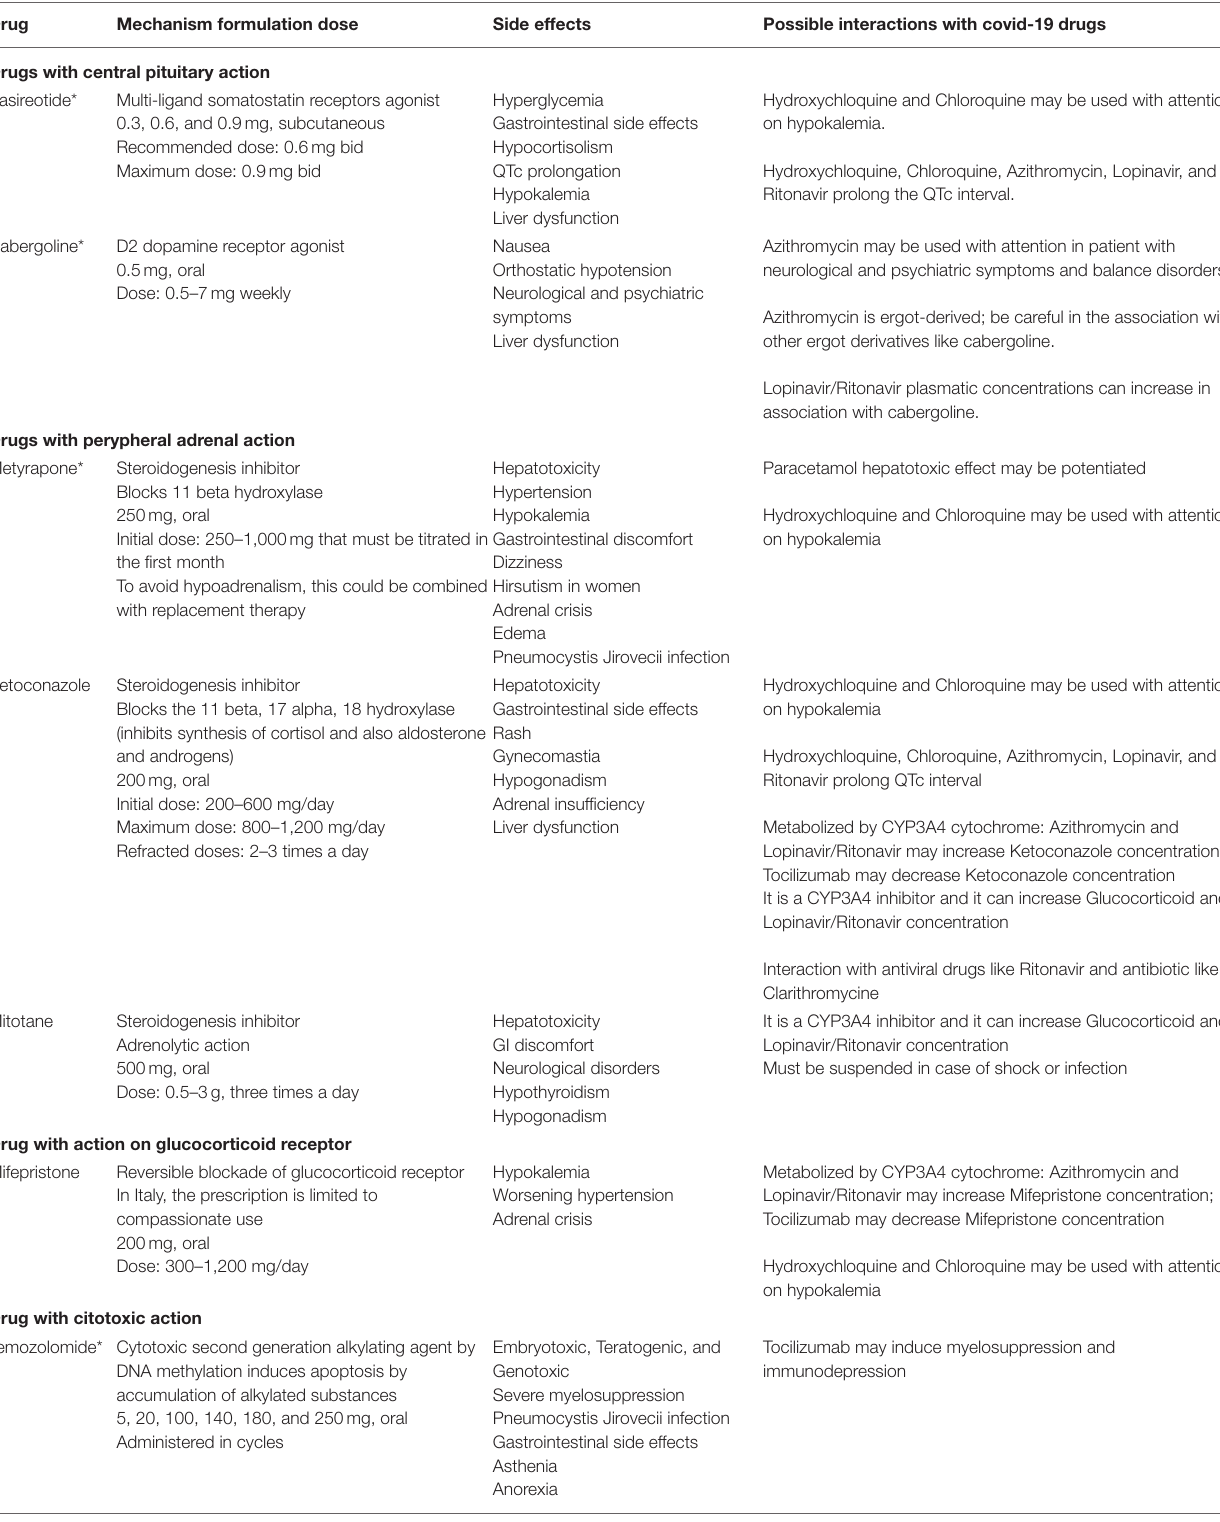
TABLE 2 | Cushing’s syndrome drugs’ characteristics and possible interaction with COVID-19 medications.